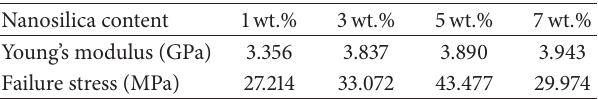
Table 2: The average modulus and failure stress values for different nanocomposites in